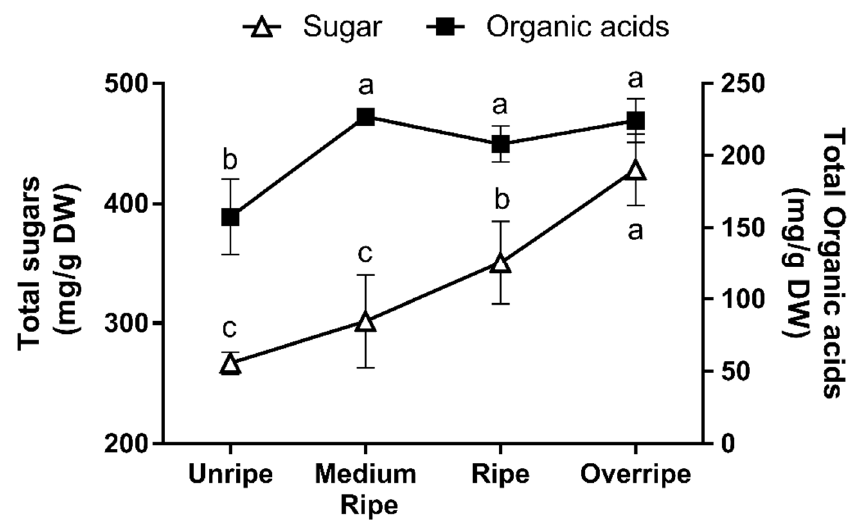
Figure 2. Total sugars and total organic acids (mg/g dry weight) (DW) during the development stages of H. edulis fruit: unripe, medium ripe, ripe, and overripe. Values represent means ± S.E. Different letters indicate significant differences according to the Tukey test ( p ≤ 0.05). Table 2. ANOVA for sucrose (SUC), glucose (GLU), fructose (FRU), glucose/fructose ratio (GLU/FRU), total sugars/total organic acids (TS/TA), and starch (STR) expressed in dry weight and considering the four development stages of H. edulis “ubajay” harvested in Moreno (Buenos Aires). Values represent means ± standard error.